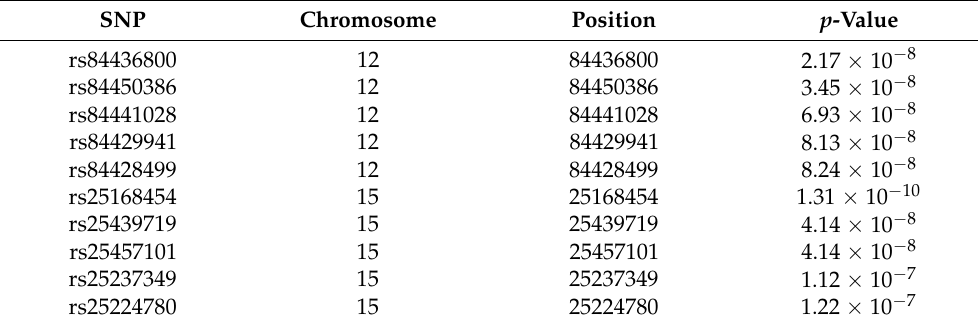
Table 3. SNPs in segment 2 associated with hind leg circumference, as determined by NGS dataset analysis.